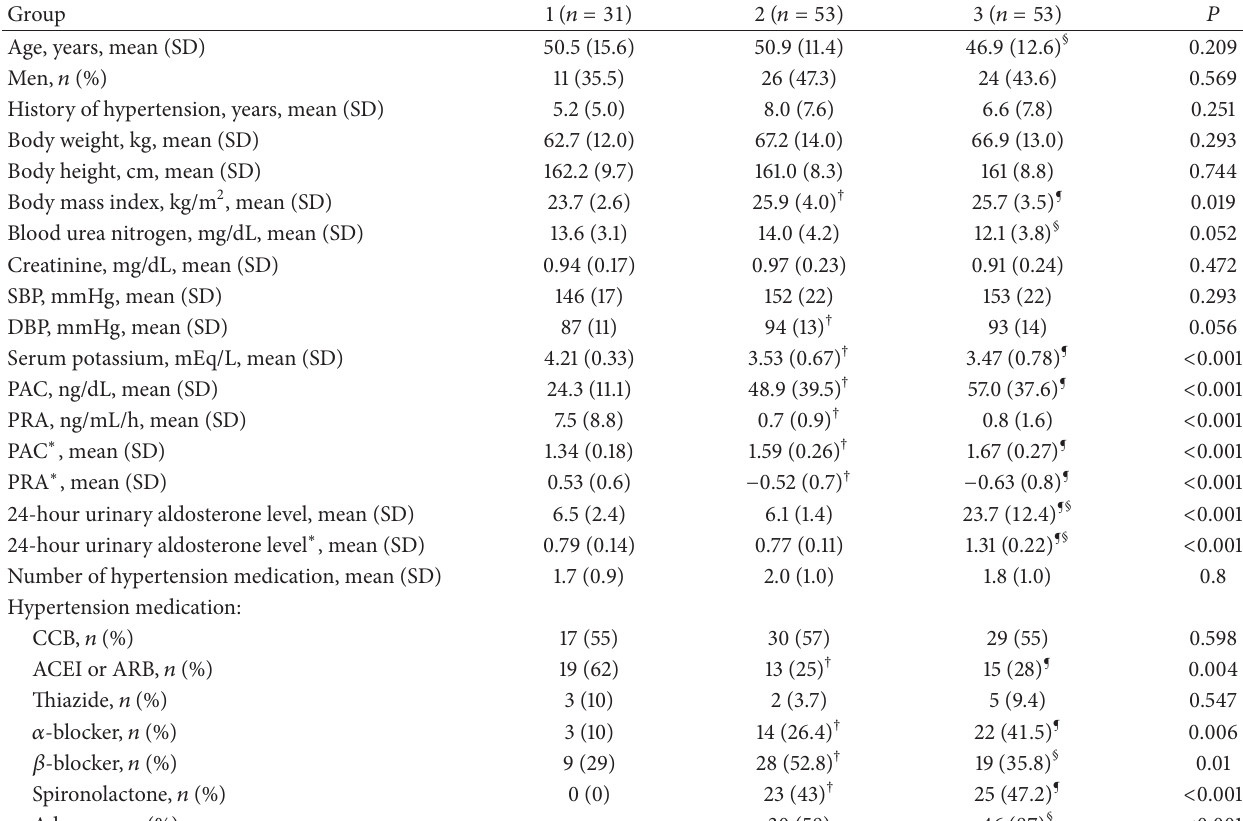
Table 1: Clinical data of